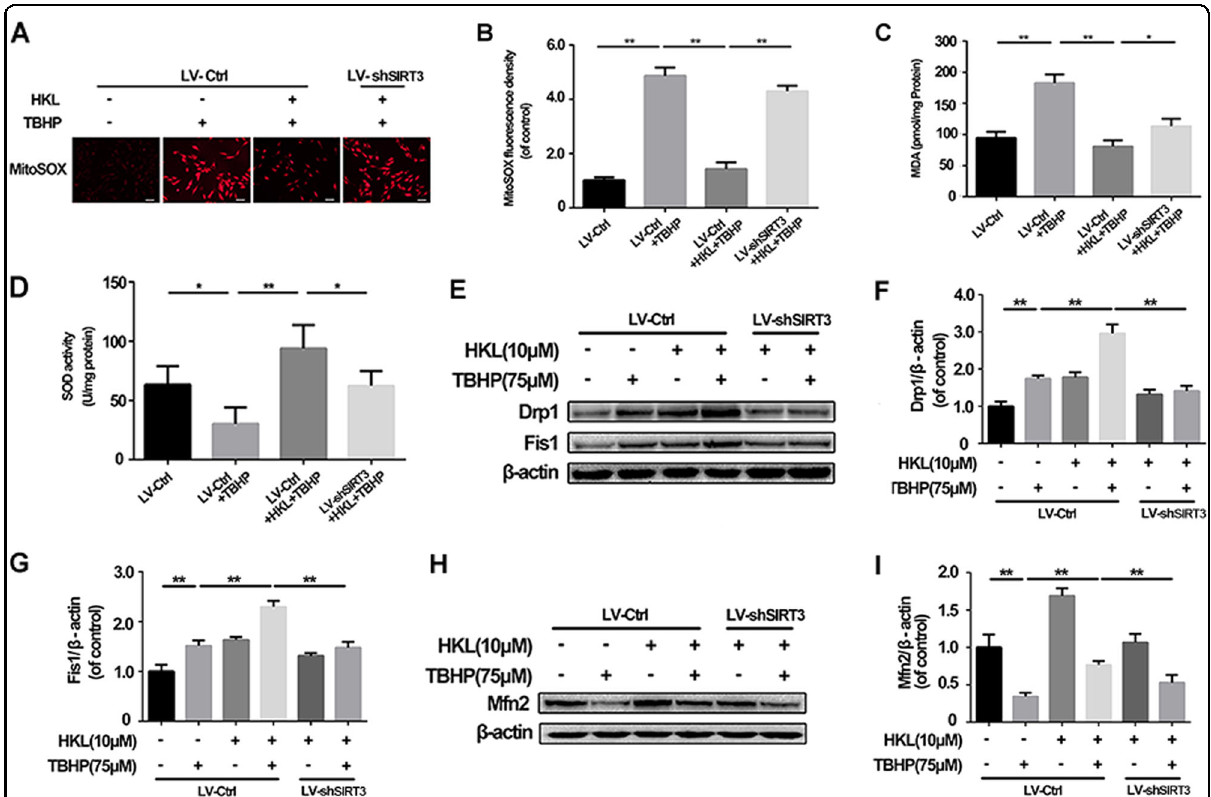
Fig. 4 HKL promotes the capacity of mitochondrial anti-oxidation and dynamics in a SIRT3-dependent manner in rat NPCs. a, b Representative micrographs showed MitoSOX red fl uorescence in no knockdown or SIRT3 knockdown in NPCs with or without treatment of HKL or TBHP. Scale bar: 20 μ M. c Regulation of MDA in NPCs under conditions of oxidative stress with or without HKL and SIRT3 knockdown. d TBHP reduced activity of SOD in NPCs, which was increased with the treatment of HKL by activating SIRT3. e – g Effect of HKL on expression of the mitochondrial fi ssion dynamic markers Drp1 and Fis1. h, i Diagrams show the effect of HKL on the expression of the mitochondrial dynamic marker Mfn2. All experiments were performed in duplicate, and data are reported as the mean ± SD. * P < 0.05, ** P <